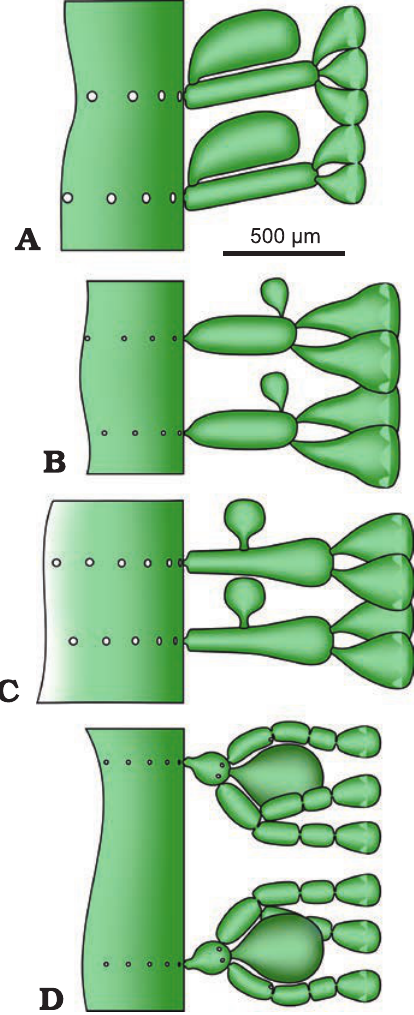
Fig. 16. Early Jurassic goniospore (A–C) and choristospore (D) Dasy cla- dales. A . Cylin droporella ? liasica (Lebouché and Lemoine in Granier and Deloffre, 1994), redrawn from Barattolo and Parente (2000). B . Chi nia nella ellenbergeri (Lebouché and Lemoine in Granier and Deloffre, 1994) Granier, Masse, and Berthou, 1994, emend. nov. C . Granieria iberica (Dragastan and Trappe, 1986) Barattolo and Romano in Barattolo et al., 2008, redrawn from Barattolo et al. (2008). D . Eodasycladus barrabei (Lebouché and Lemoine in Granier and Deloffre, 1994), redrawn from Barattolo et al.